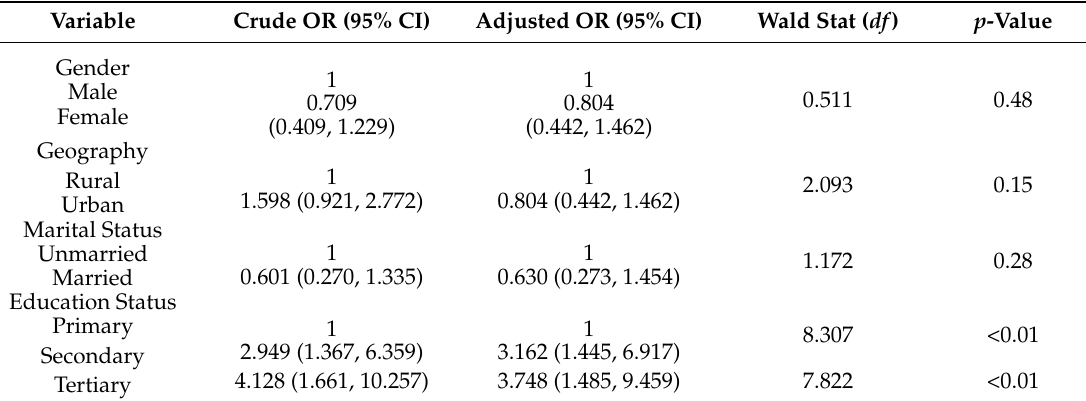
Table 5. Associated factors for positive belief toward leptospirosis using multiple logistic regression ( N = 214).